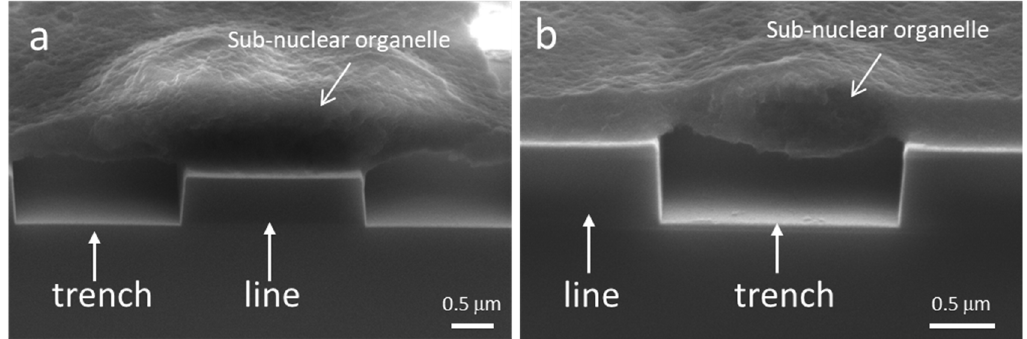
Figure 9. Micrographs show cell adhered to the 2 µ m comb structures. ( a ) The sub-nuclear organelle resting on the line is shown in ( a ) while the organelle sat in the trench is shown in ( b ).